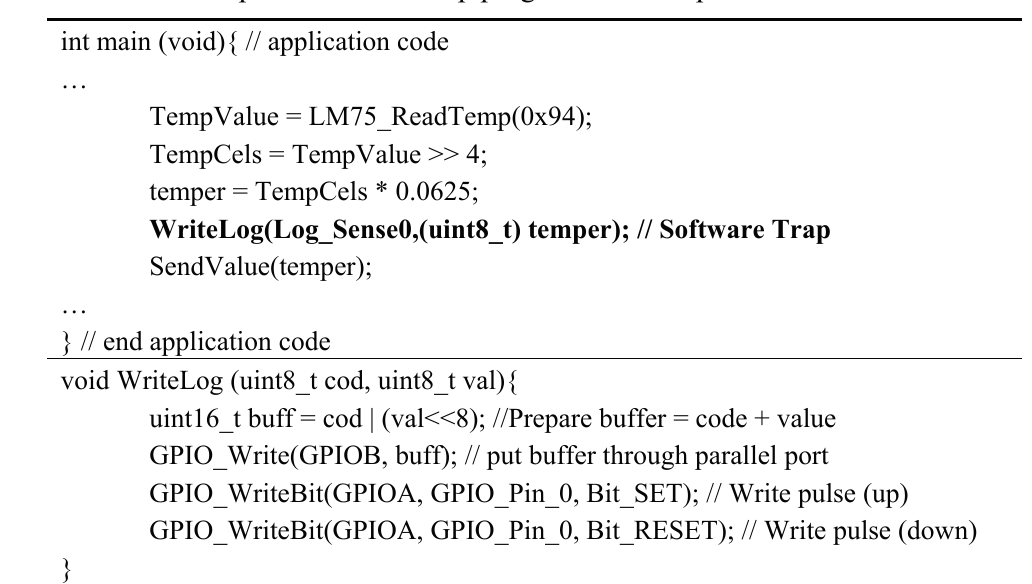
Table 2. Sample of software trap program code for parallel